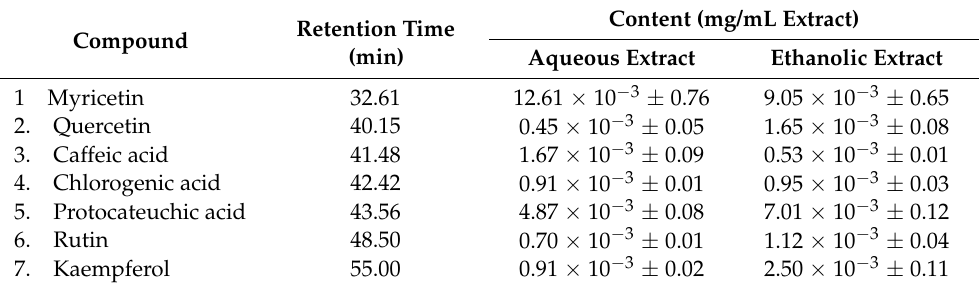
Table 2. HPLC profile and content of selected polyphenols from S. nigra flowers extracts. Data are mean ± SD, n =